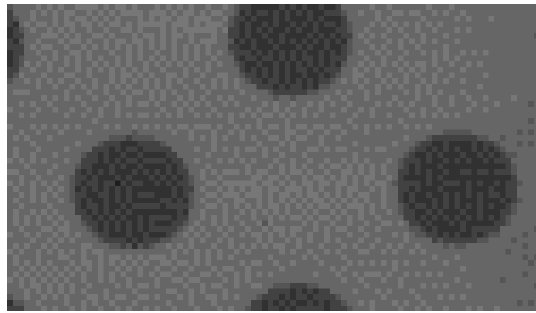
Figure 16. The close-up on the calibration pattern. A huge amount of noise is noticeable.